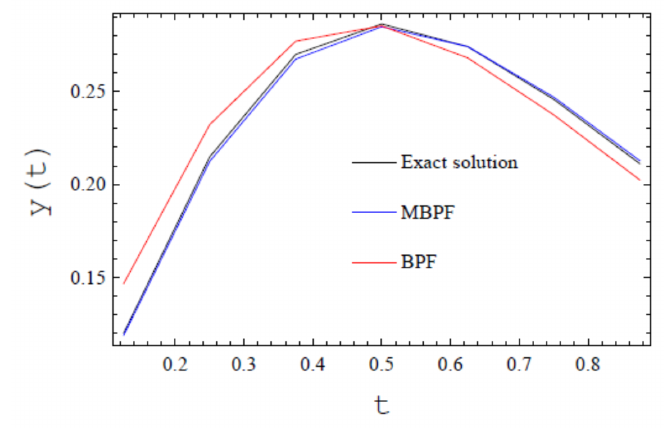
Figure 5. The absolute error of IBPFs and BPFs expansions comparison at the midpoints of the intervals of IBPFs.